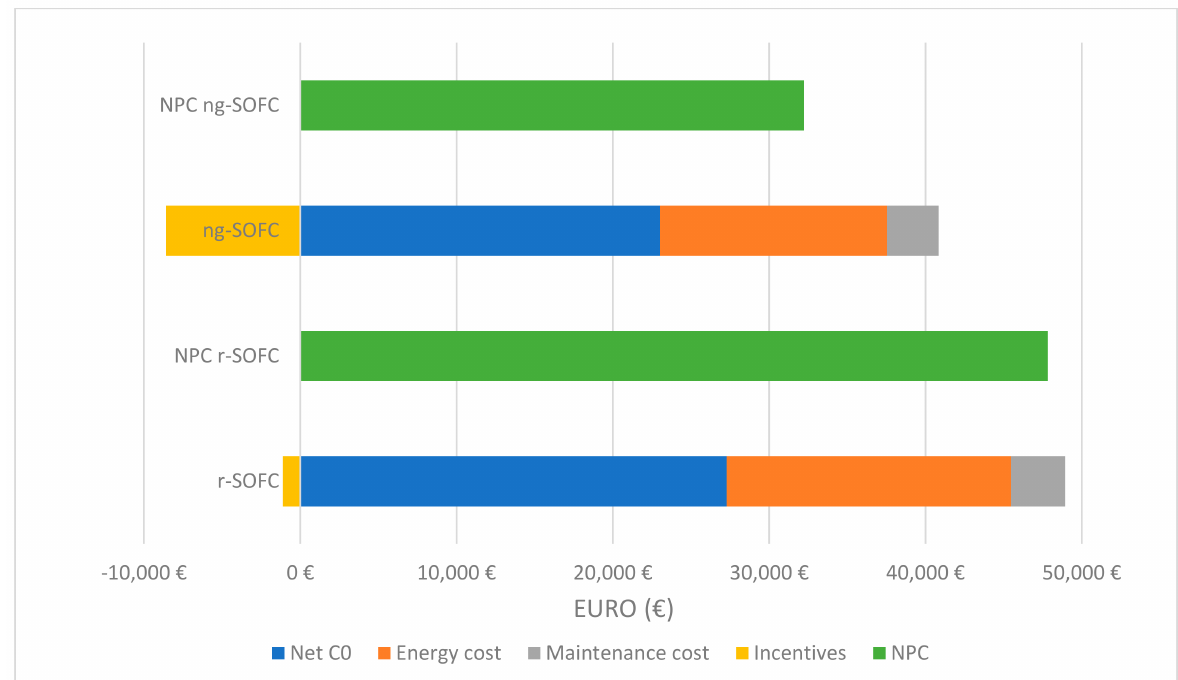
Figure 2. Costs and incentives of the systems in the “net metering” scenario.